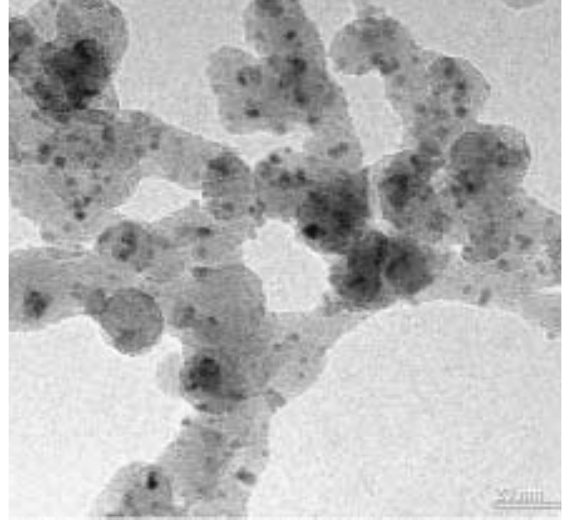
Fig. 20 TEM of iron oxide/ silica nanocomposite.